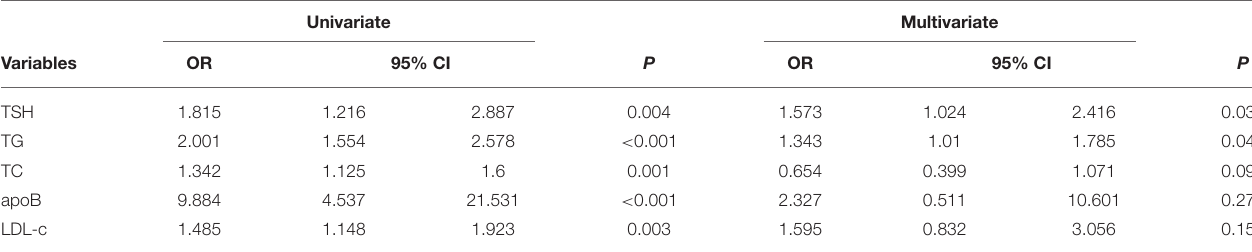
TABLE 4 | Binary logistic regression with HA as output variable.